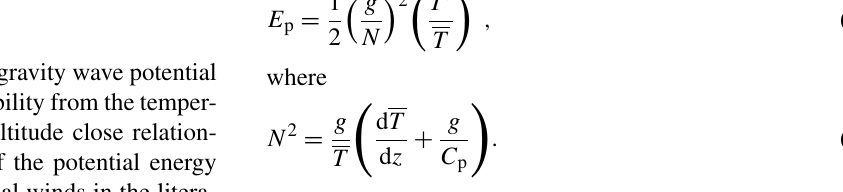
Figure 1. Local time coverage of the temperature data observed by the K-Doppler lidar at Arecibo from December 2003 to Jan- uary 2010, and from November 2015 to April